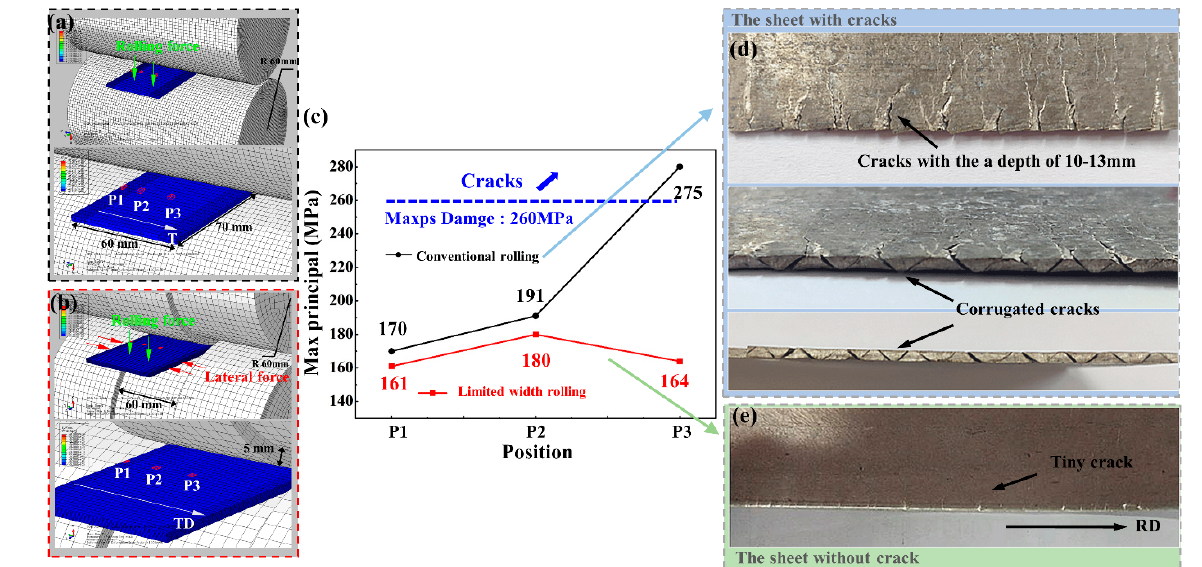
Figure 1. Schematic diagrams of rolls and ABAQUS model: ( a ) conventional rolling; ( b ) limited width rolling. ( c ) Max principal (Abs) of P1, P2, and P3 on the sheets at rolling time. ( d , e ) Edge crack situation of the sheets.